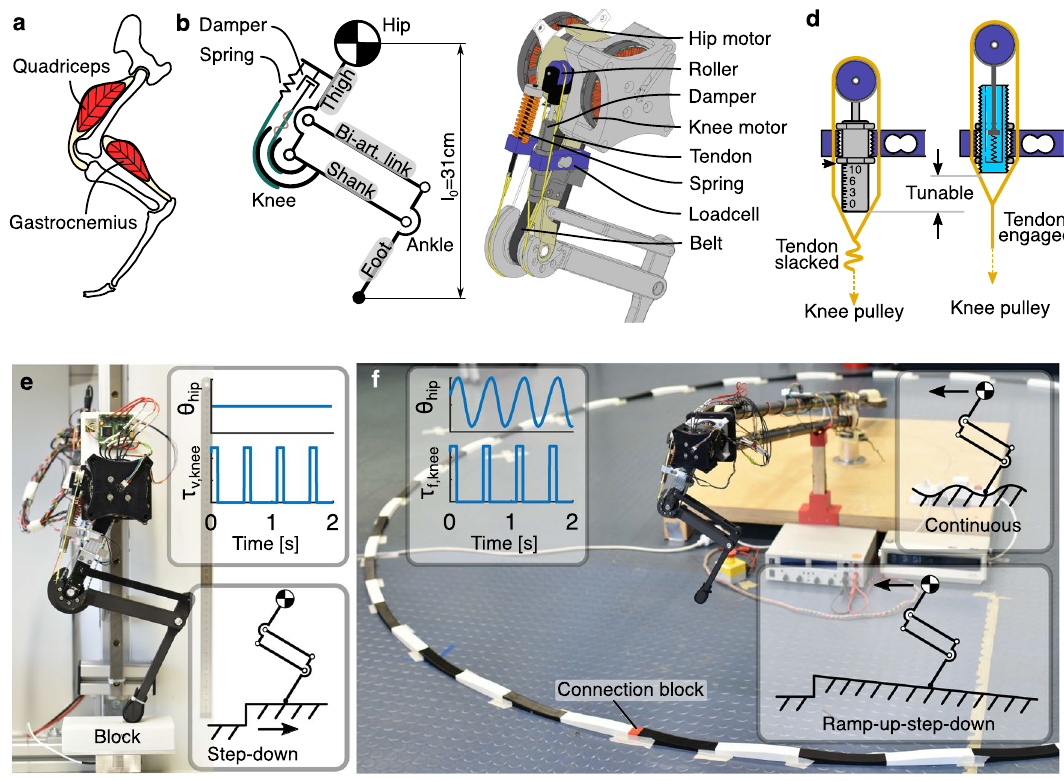
Figure 5. Experiment setup overview. ( a ) Our leg design is inspired by the leg anatomy of mammalian quadrupeds. ( b ) We implement a pantograph leg design with spring and damper representing the passive compliance of the quadriceps and a biarticular segment, simplifying the gastrocnemius muscle and the Achilles tendon. ( c ) The rendering of the leg design shows that the knee joint is coupled to the linear spring, the linear damper through tendons, and the knee motor through a timing belt. ( d ) The slack damper mechanism is realized by the threaded connection between the damper and the loadcell. By rotating the damper, the damper will travel up and down, thus allowing tunable tendon slack. The left schematics illustrates the lowest position of the damper in maximum tendon slack, and the right schematics demonstrates the inner mechanics of the hydraulic damper with minimum tendon slack. ( e ) The vertical hopping setup fixes the robot leg on a vertical slider to test step-down perturbation, which is introduced by removing the perturbation block on top of the force sensor. The top right shows a feed-forward control pattern for hip position and knee torque. ( f ) The forward hopping setup fixes the robot leg on a rotary boom to test continuous perturbation (in photo) and ramp-up-step-down perturbation (Supplementary Movie S3). The top right shows a feed-forward CPG control pattern for hip position and knee